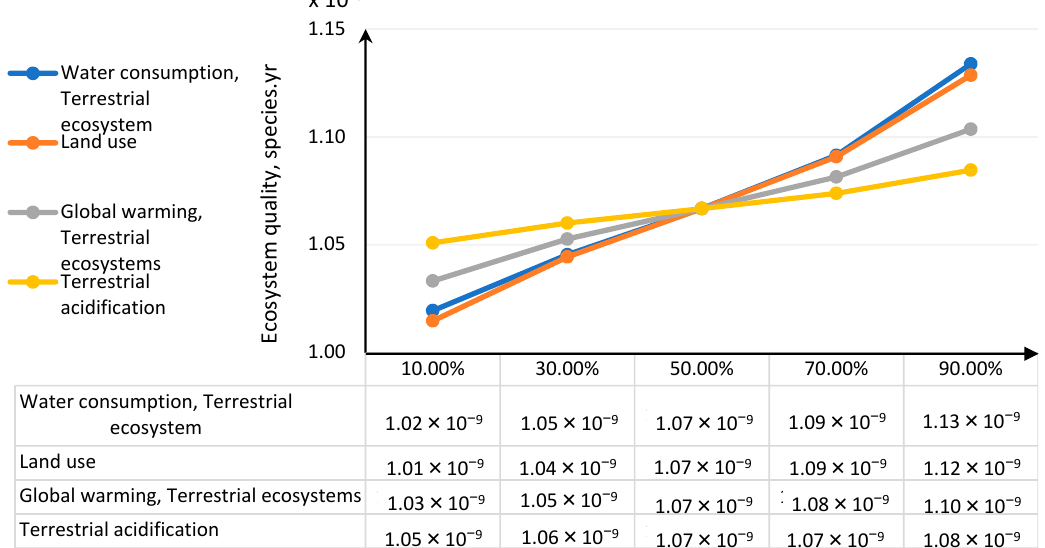
Figure 21. Spider chart of sensitivity for the ecosystem quality damage category.